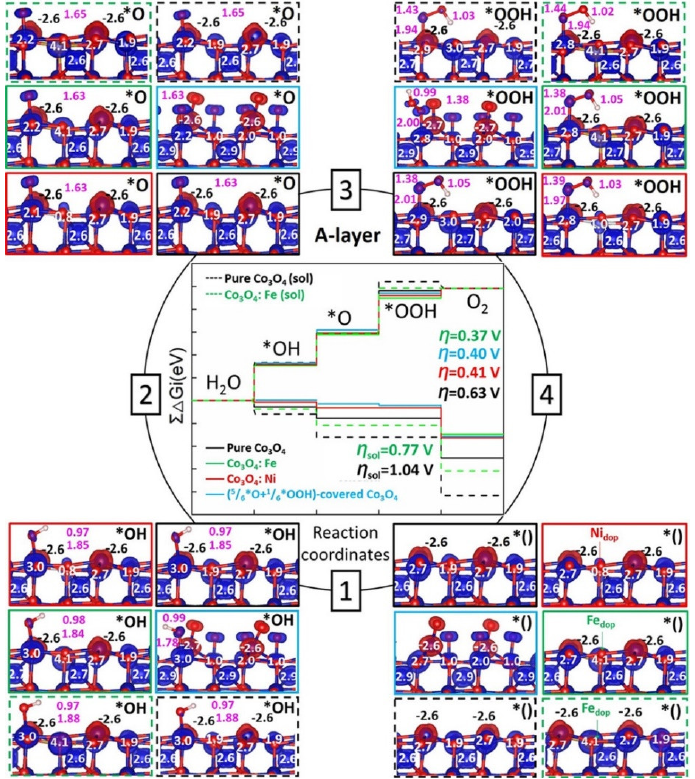
Figure 27. OER cumulative free energies ∑Δ G i of step(1)–(4) at the A-layer. The side view of the intermediates with the corresponding spin-density is displayed. Additionally, the magnetic moments are given in μ B in black or white and bond lengths in Å in magenta. Black, green, and red frames denote the undoped, Fe-, and Ni-doped Co 3 O 4 (001) surfaces, respectively; the dashed lines indicate the calculations including solvation effects. (Reprinted from ref. [165] with permission from the ACS Catalysis © 2021, American Chemical Society).